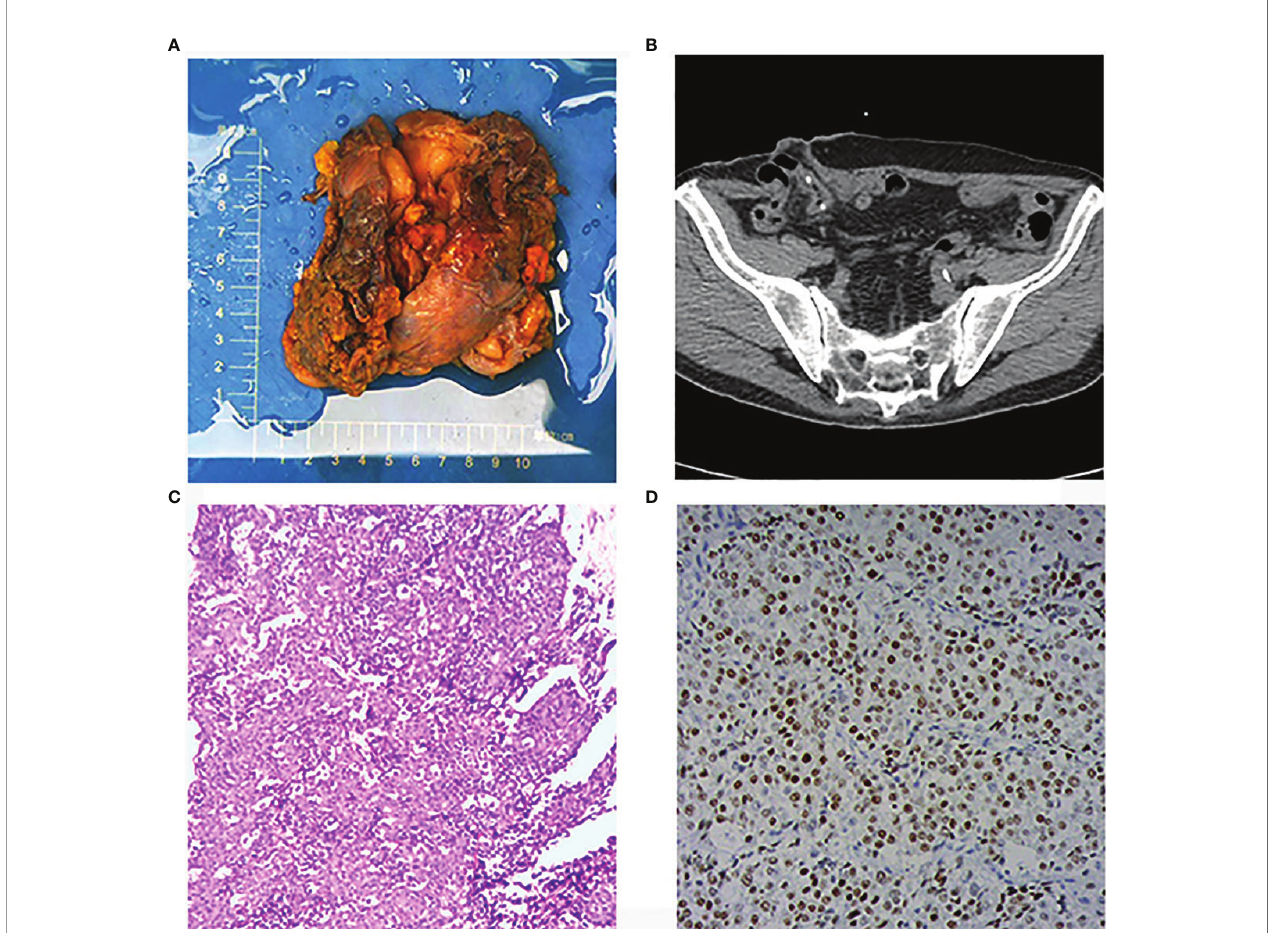
FIGURE 3 | (A) Grossspecimenoftheprostatewithasmallbladdertissue. (B) Ileocystoplastywasperformedandanewurinaryexcretorysystemwasreconstructed. (C) H&E stainingofbladderinvasionlesionsshowingpoorlydifferentiatedprostaticadenocarcinomawithaGleasonscoreof5+5=10. (D) Immunohistochemicalstainingresult,NKX3.1(+).